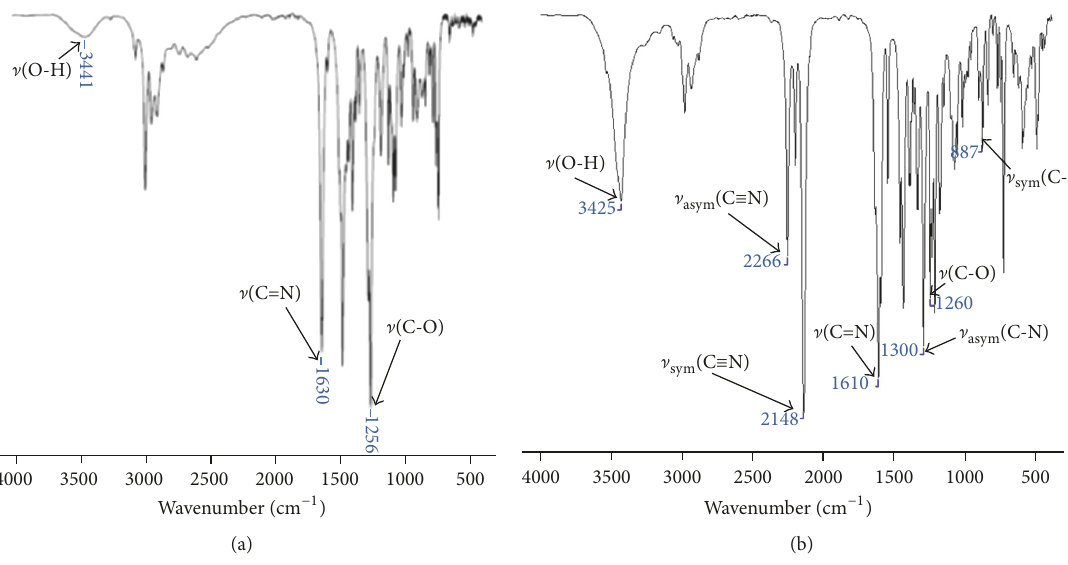
Figure 3: Comparison between the spectra for the free ligand H 2 L 2 (a) and complex 2 (b).